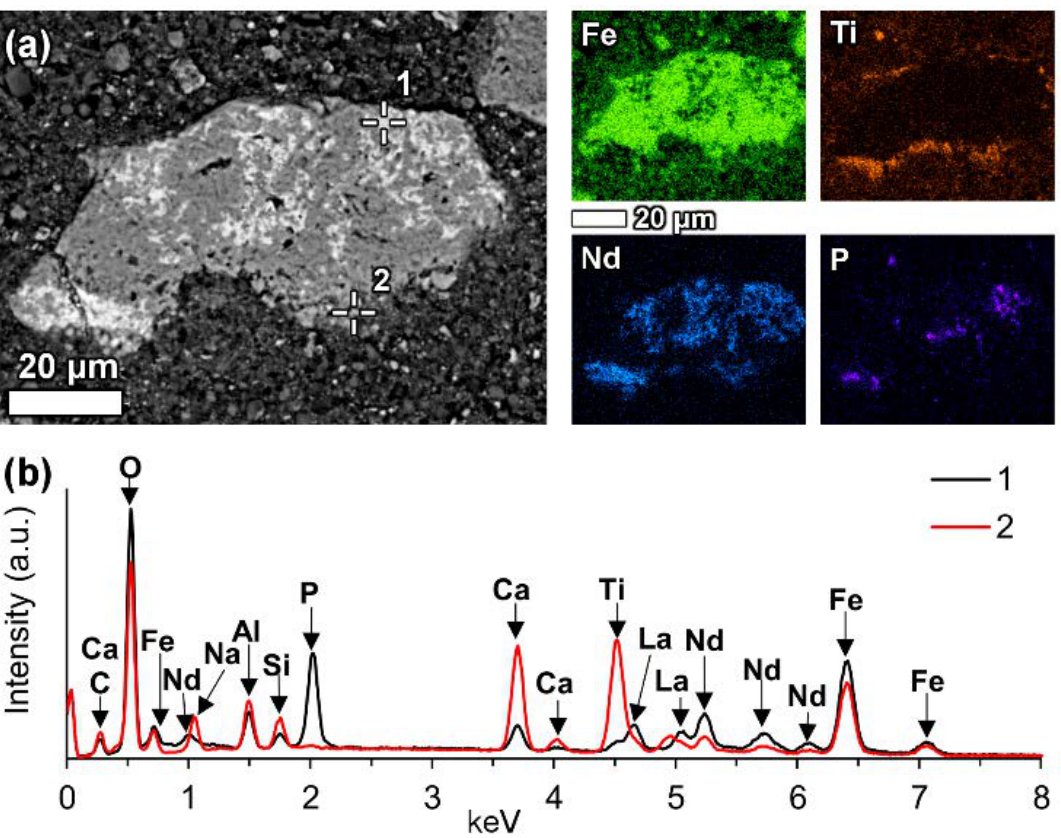
Figure 17. Mixed LREE phases entrapped in iron oxide grain depicted on ( a ) backscattered electron image and respective EDS elemental maps and ( b ) corresponding EDS spectra. Element maps are monochromatic, thus there is no colour intensity scale.